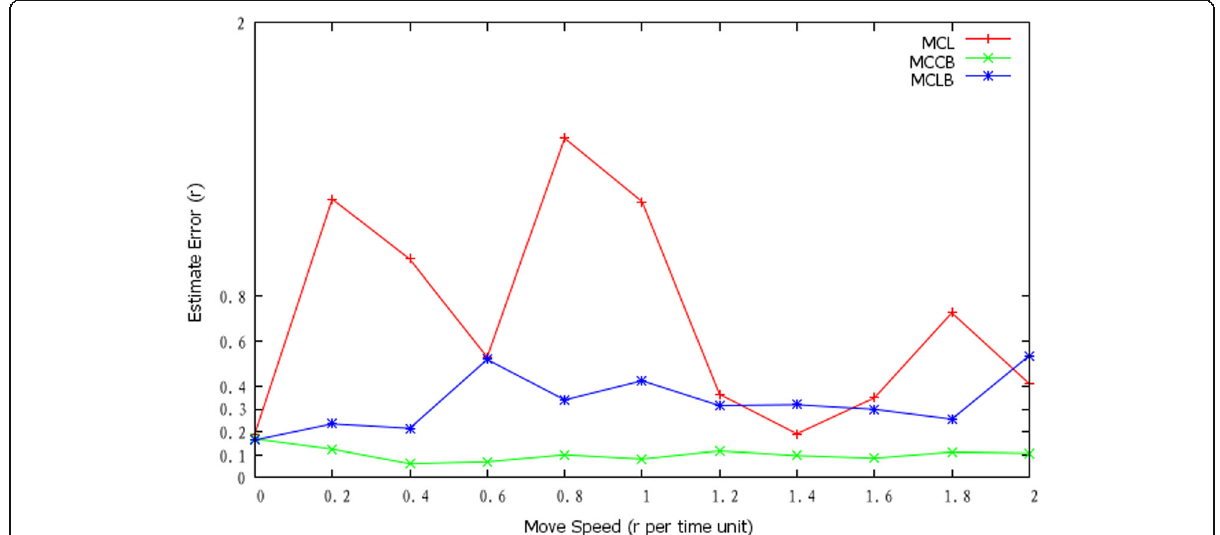
Fig. 8 Roadway width at 5 m comparison chart. For a roadway width at 5 m under conditions, MCCB precision accuracy is still the best. As can be seen, the coverage area is much larger than the width of the roadway, and with the roadway width becoming smaller, the positioning accuracy of the positioning method has all the mentioned precision at about 10%